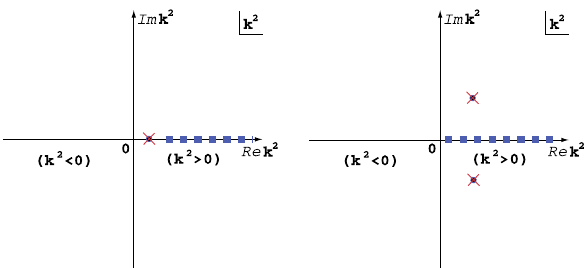
Fig. 15 Possible singularities of the propagator on the complex k 2 plane, (left) a real pole and the branch cut on the positive real axis, (right) a pair of complex conjugate poles and the branch cut on the positive real